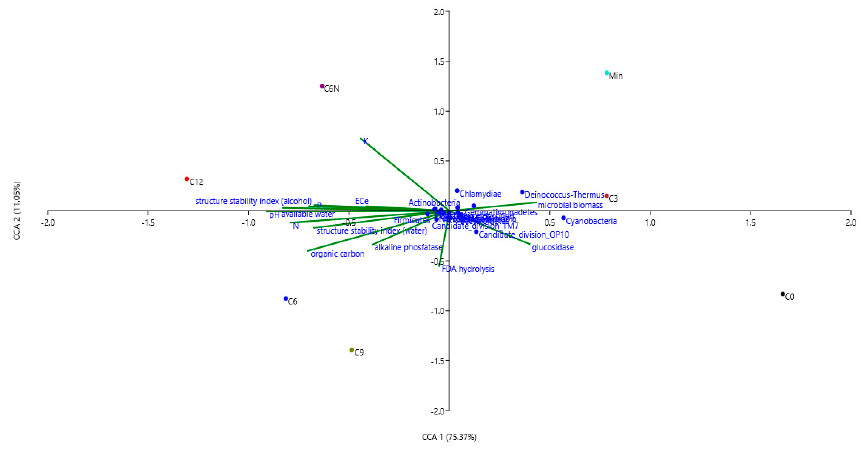
Figure 7. Canonical correspondence analysis (CCA). Relationships between environmental variables and microbial community. C0, unfertilized soil; C3, C6, C9 and C12 = 3, 6, 9 and 12 Mg/ha sewage sludge compost, respectively; C6N, combined application of 6 Mg/ha of sewage sludge and 60 kg/ha N; Min, mineral fertilization.